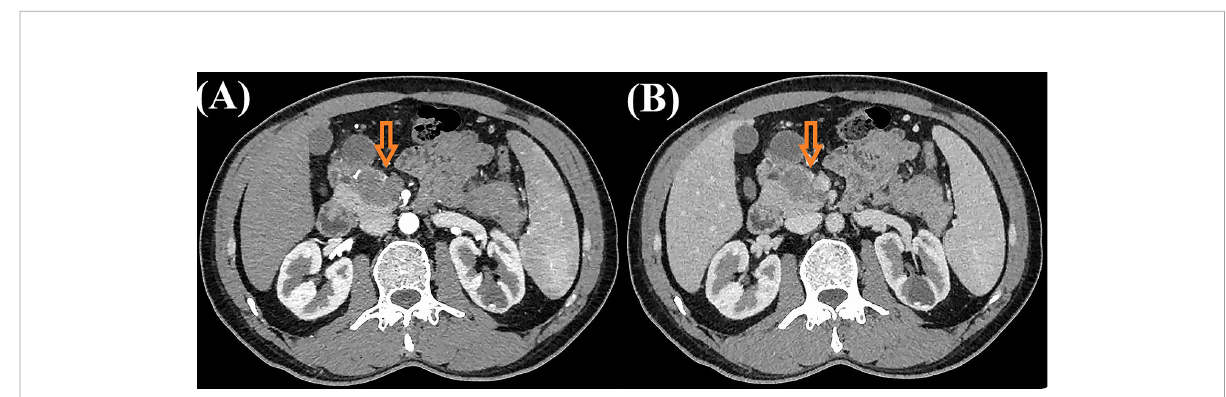
FIGURE 2 Contrast-enhanced computed tomography images of the patient. Contrast-enhanced computed tomography showed both hypo-enhancement masses in the arterial phase [ (A) , orange arrow)] and venous phase [ (B) , orange arrow)].